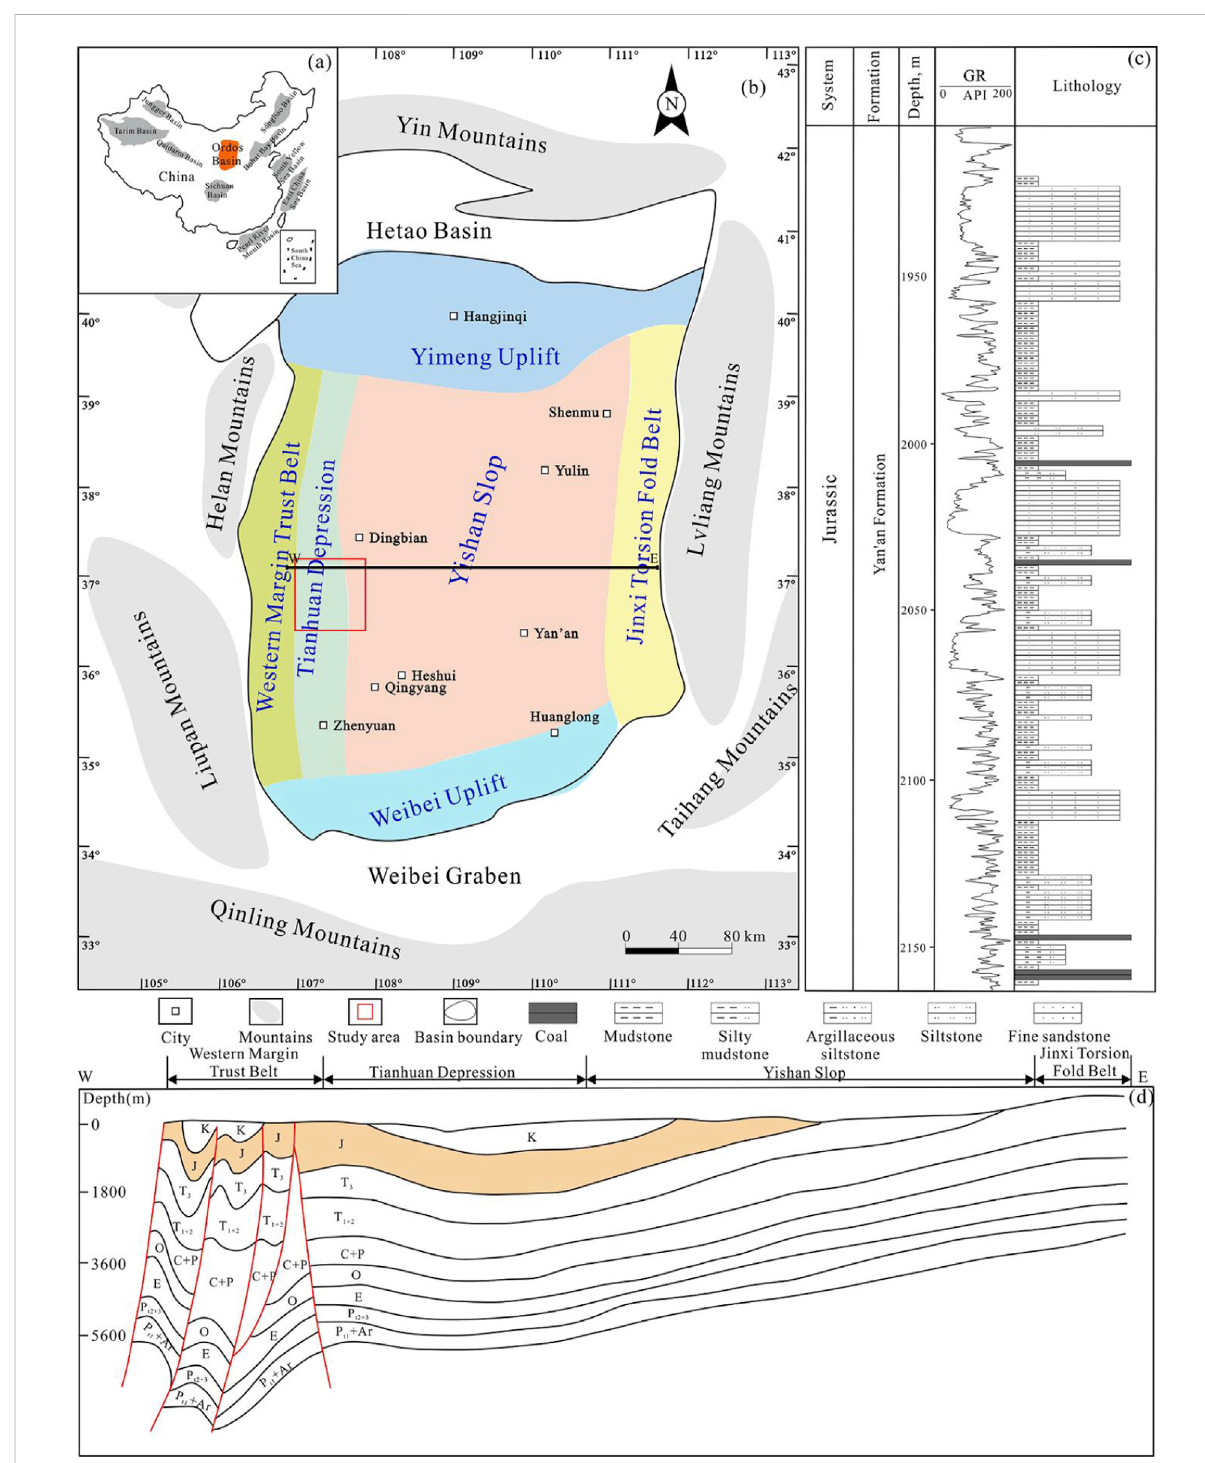
FIGURE 1 The study area is located in the western margin of the Ordos Basin in the western part of the North China Craton (NCC) (Zhong et al., 2021). Notes: (A) Location of the Ordos Basin; (B) Location of the study area; (C) Lithologic characteristics of the Yan ’ an Formation coal measures; (D) A stratigraphic pro fi le in the central part of the Ordos